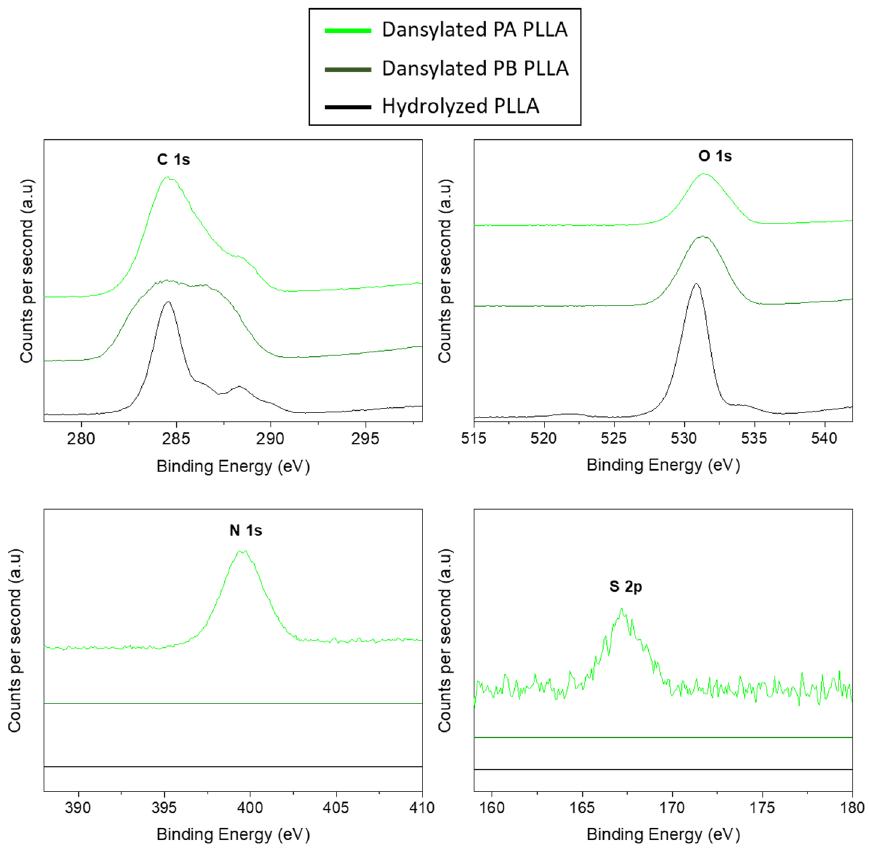
Figure 3. XPS spectra of different modified PLLA surfaces.